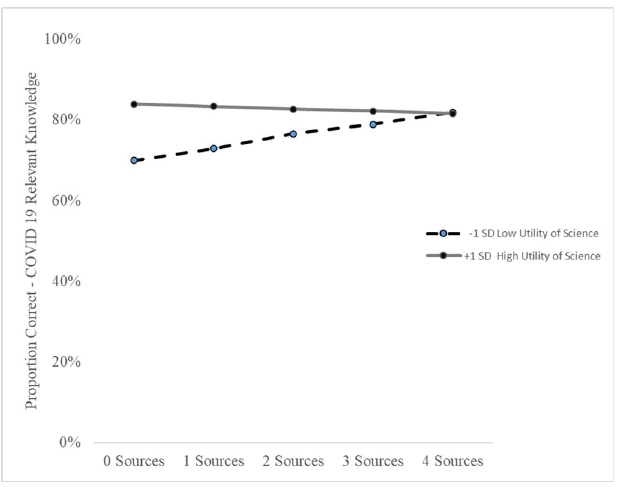
Fig 2. Proportion accurate COVID-19 relevant knowledge by number of sources and attitude about the utility of science for health.